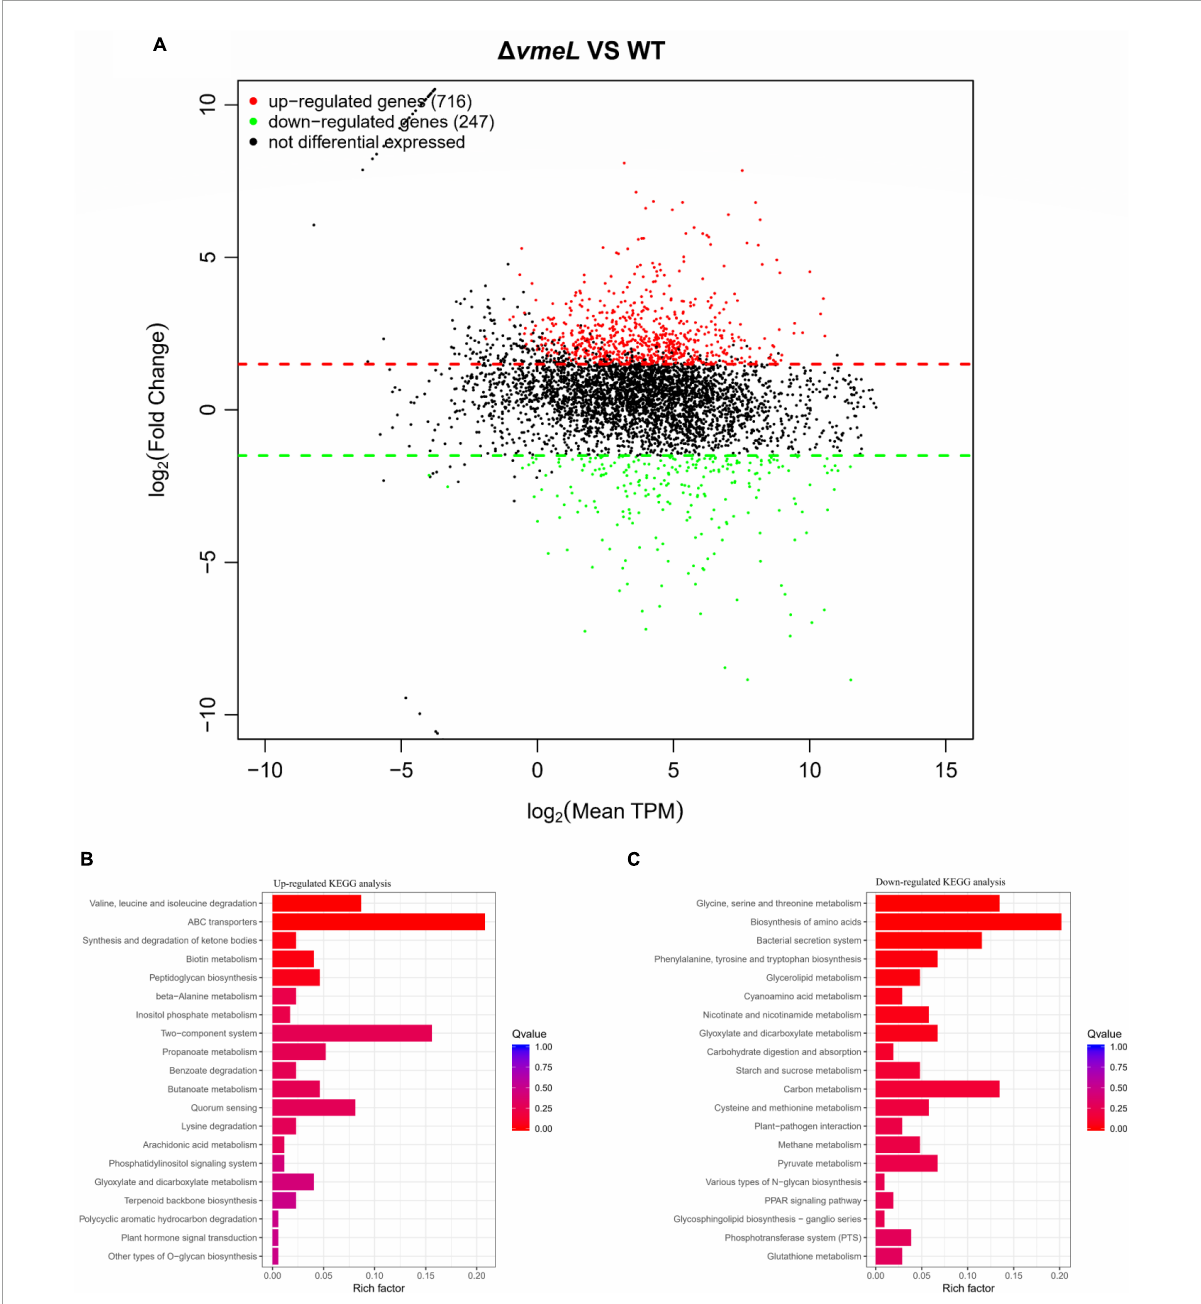
FIGURE6 Transcriptomic analysis between (cid:49) vmeL and WT strains of Vibrio parahaemolyticus . (A) MA plot shows the DEGs of (cid:49) vmeL and WT. DEGs with log2FC > 1.5 are denoted in red, and DEGs with log2FC < 1.5 are denoted in green ( P < 0.01). TPM indicates transcripts per kilobase of exon model per million mapped reads. (B,C) KEGG pathway enrichment analysis for (cid:49) vmeL and WT strains. The color of the bar corresponds to different ranges of Q values (adjusted P values). WT, wild-type; (cid:49) vmeL , vmeL deletion mutant; C (cid:49) vmeL , deletion mutant complemented